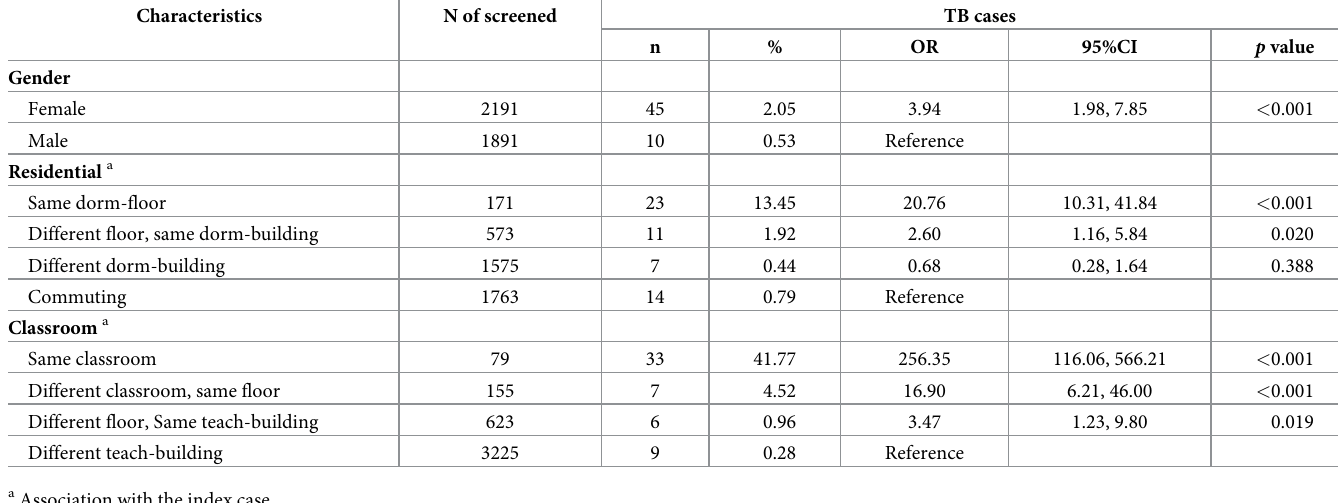
Table 6. Distribution, unadjusted OR and 95% CI for characteristics of students on TB cases.